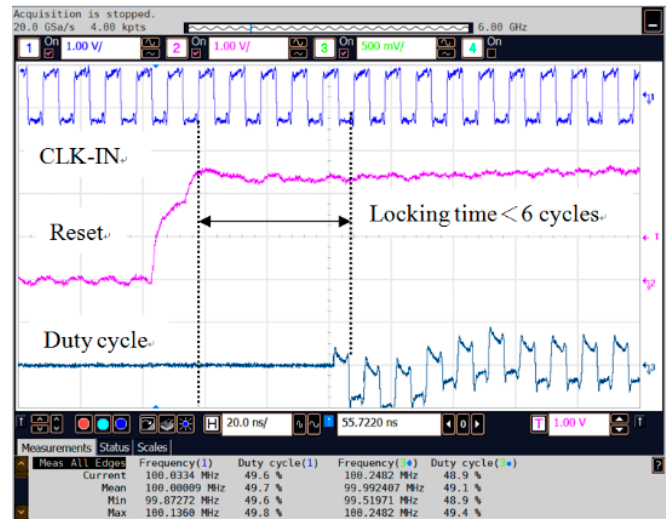
Figure 11. Locking time measurement results.